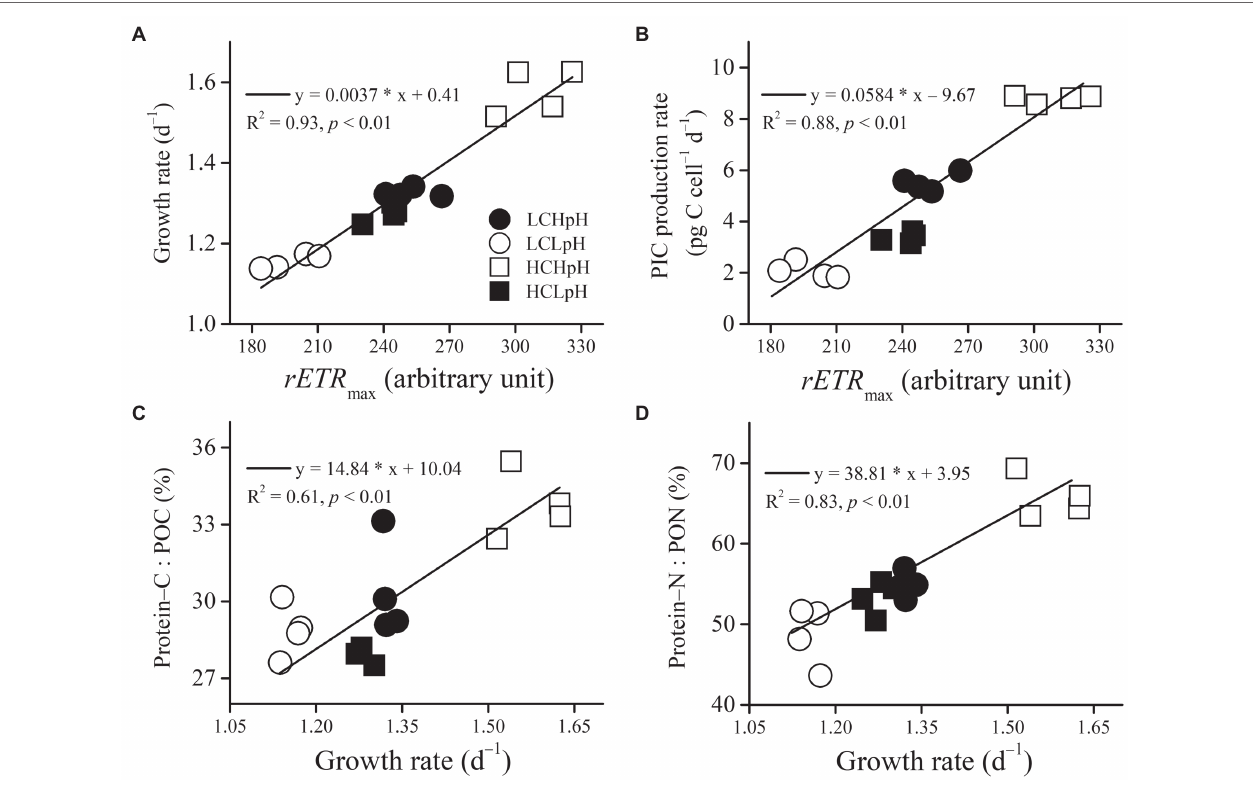
FIGURE 6 | Relation between rETR max and (A) growth rate or (B) PIC production rate, and relation between growth rate and (C) percentage of POC allocated to protein or (D) percentage of PON allocated to protein of E. huxleyi RCC1266. Line in each panel was fitted based on data of four independent cultures under each treatment condition. For more information, please see Figure 1